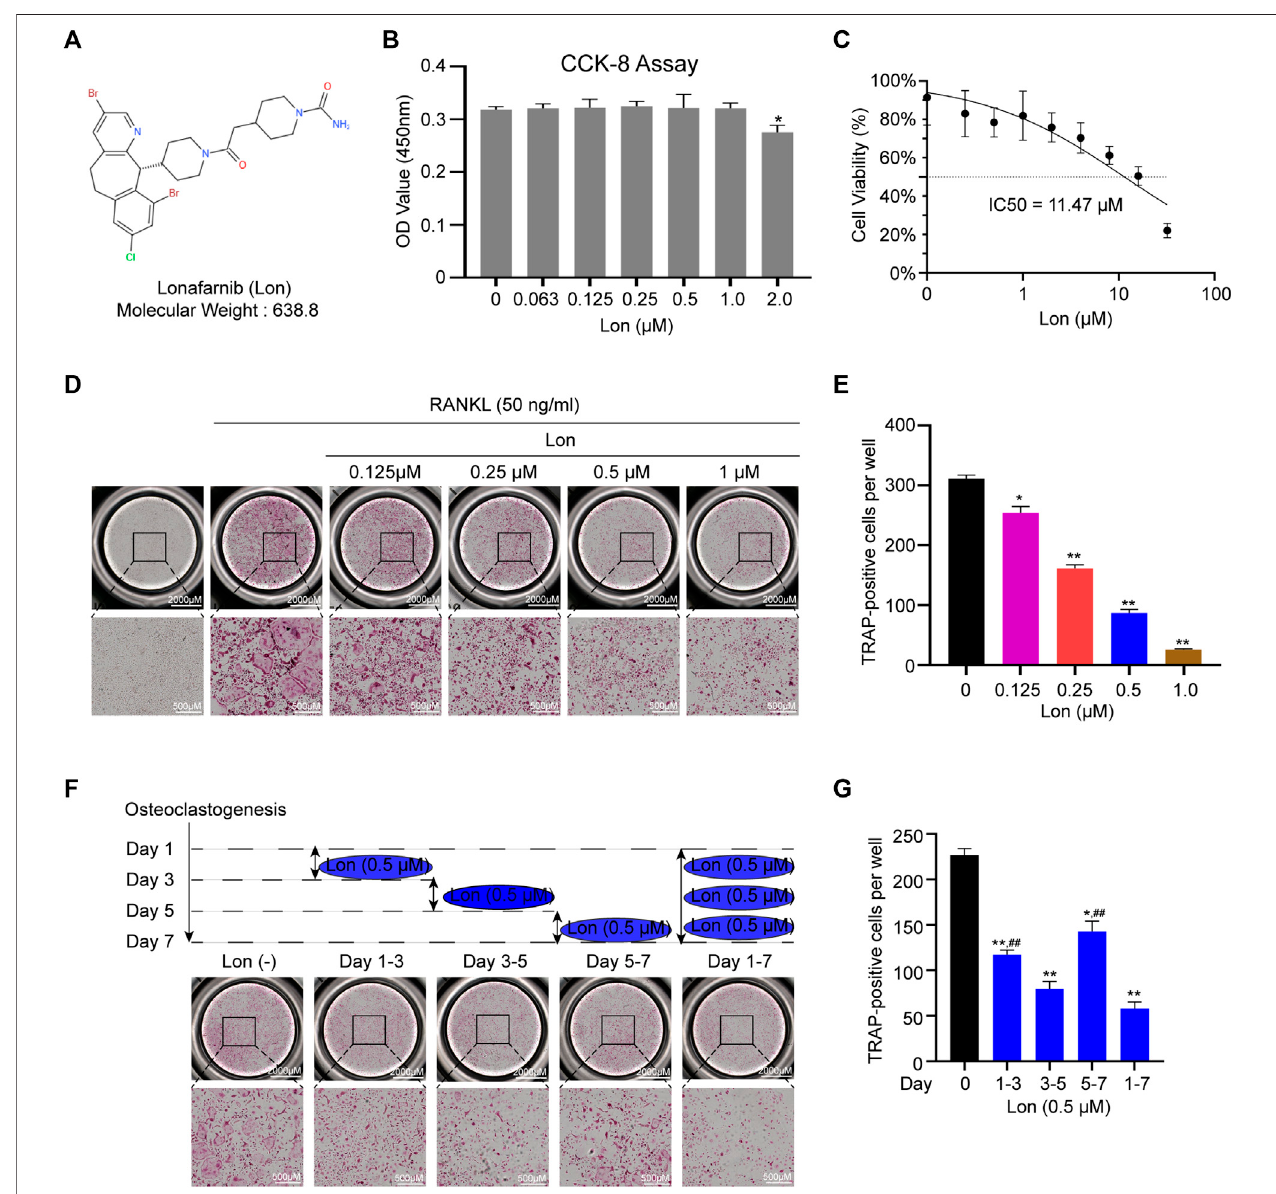
FIGURE1| Lonsuppresses RANKL-inducedosteoclastogenesis invitro . (A) Themolecularstructure andweightofLon. (B) ThecytotoxicityofLonagainstBMMs at 48 h after treatment was investigated by CCK-8 assay. (C) IC50 for Lon against BMMs at 48 h was calculated. (D) Representative images of TRAP staining showing thatLoninhibitedosteoclastogenesisinadose-dependentmanner. (E) Quanti fi cationofmultinucleatedTRAP-positiveosteoclast(nuclei ≥ 3). (F) Representativeimages of TRAP staining showing that BMMs treated with Lon (0.5 μ M) in the certain time stages during osteoclastogenesis. (G) Quanti fi cation of multinucleated TRAP- positive osteoclast (nuclei ≥ 3) treated with Lon in the certain time stages. All of the above data are expressed as the mean ± SD, n = 3 per group, * p < 0.05, ** p < 0.01 compared with control group (without Lon treatment). # p < 0.05, ## p < 0.01 compared with the middle phase. BMMs, bone marrow macrophages; IC50, the half maximalinhibitoryconcentration;Lon,Lonafarnib;OD,opticaldensity;RANKL,receptoractivatorofnuclearfactor- κ Bligand;TRAP,tartrate-resistantacidphosphatase.